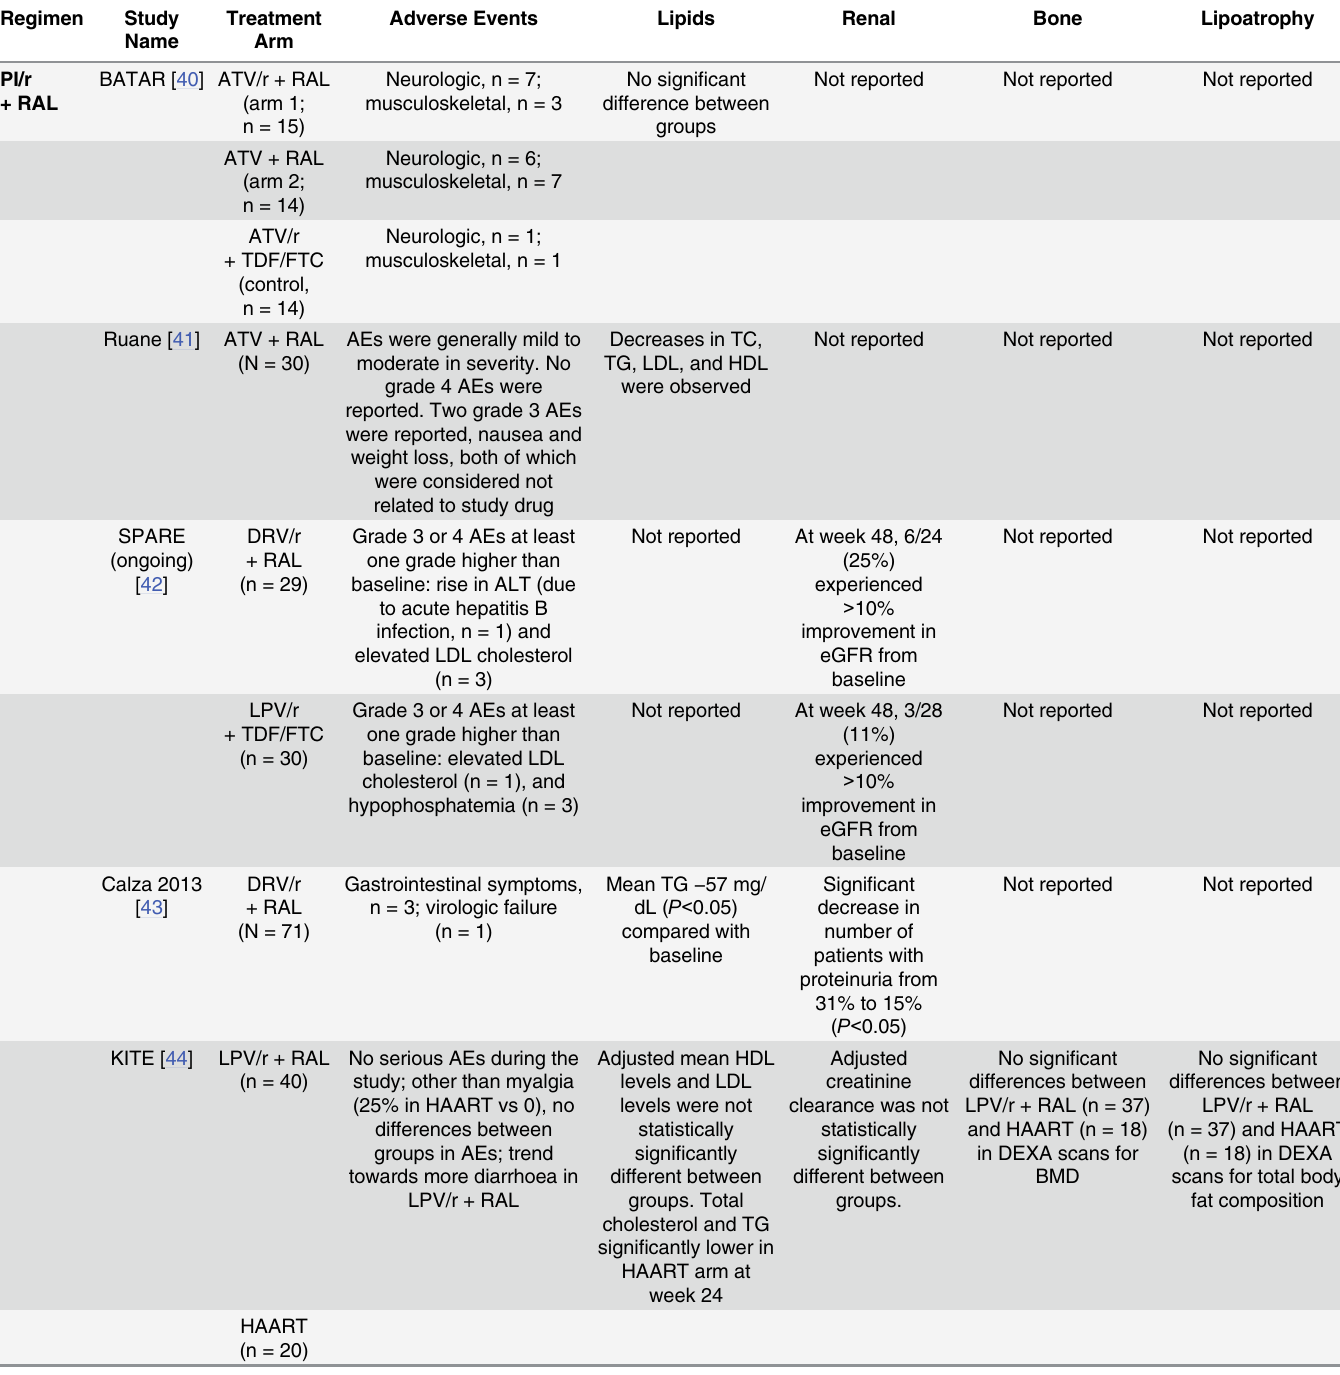
Table 6. Results of key secondary endpoints from identified trials among ARV-experienced HIV-suppressed patients.